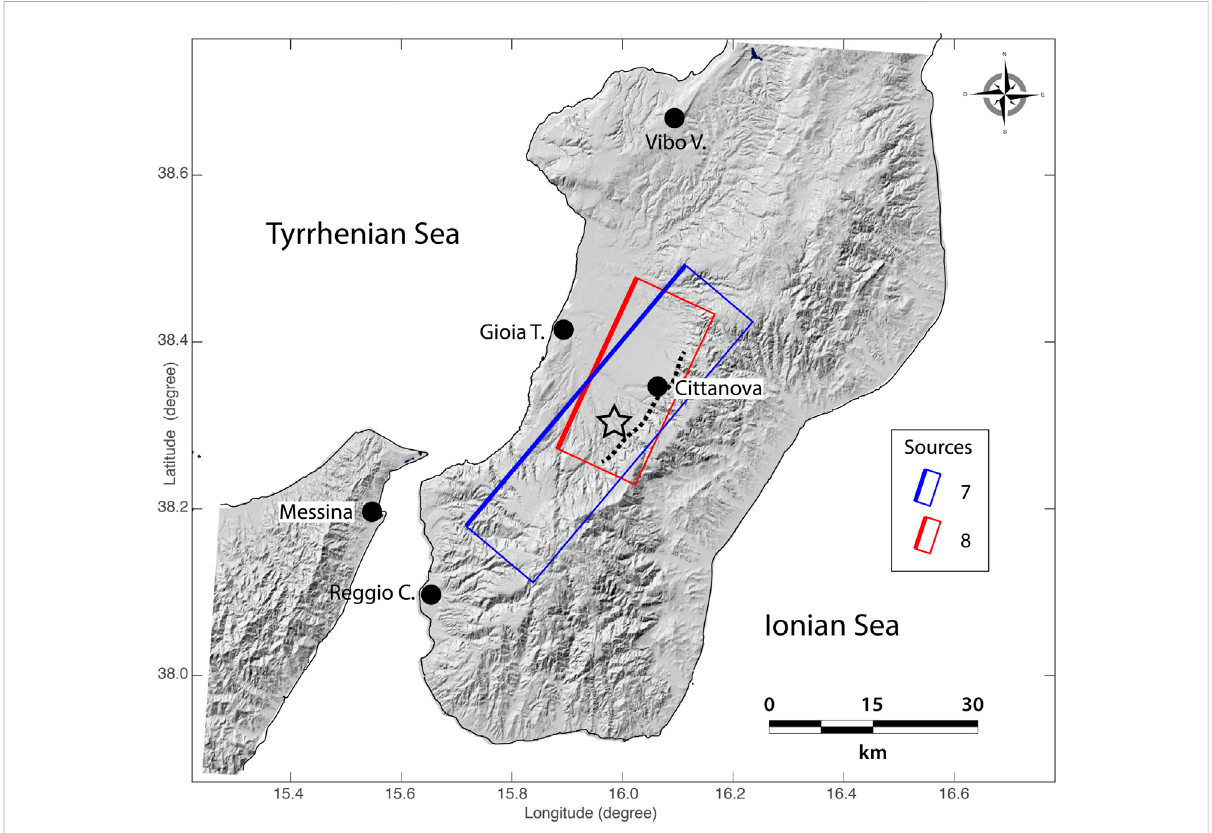
FIGURE 4 Location of the SE-verging competing potentian sources of the 1783 earthquake (epicenter shown as a black star): Boxer_SE; 8, DISS. A thicker line indicates the top egde of the source. The black dashed line marks the pattern of the surface ruptures observed in the fi eld after the